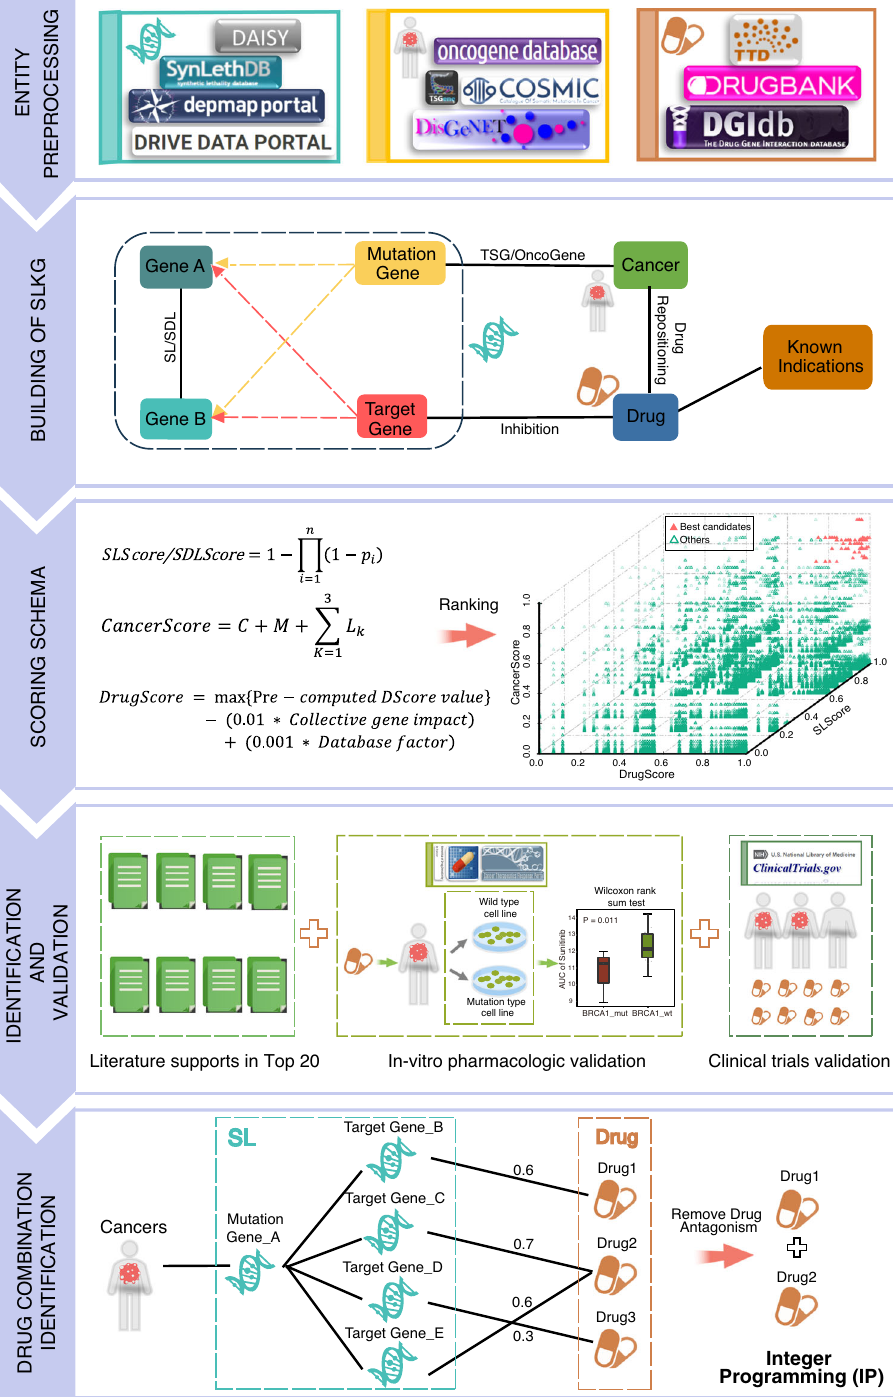
Fig. 2 The general framework of the SLKG and the following analysis. The study comprises fi ve steps: (1) Entity preprocessing: the three types of entities (gene, cancer type, and drug) are collected and analyzed to exploit the tumor therapy landscape. (2) Building of SLKG: the SLKG comprises three types of entities and four types of relationships, which forms the computational basis from a drug repositioning perspective. (3) Scoring schema: a well-de fi ned drug repositioning scoring schema by integrating three core scoring functions were developed to obtain the best repurposable drug candidates. (4) Identi fi cation and validation: the literature supports and in-vitro pharmacologic evidence were identi fi ed and validated in the top repurposable drug candidates. (5) Drug combination identi fi cation: a computational model was developed for identifying drug combinations in a weighted bipartite graph network by an IP the TTD 12 , DrugBank 13 , and DGIdb 14 databases, we further pairs, respectively. Because there is no obvious distinction organized the relationships of drugs, target genes, and known between gene A and gene B in the SL or SDL pairs, we considered indications into a knowledge graph. Based on these three types of two reciprocal scenarios during the mapping, i.e., gene A maps entities, we mapped mutants and target genes to SL or SDL gene the mutant gene and gene B maps the target gene, and vice versa